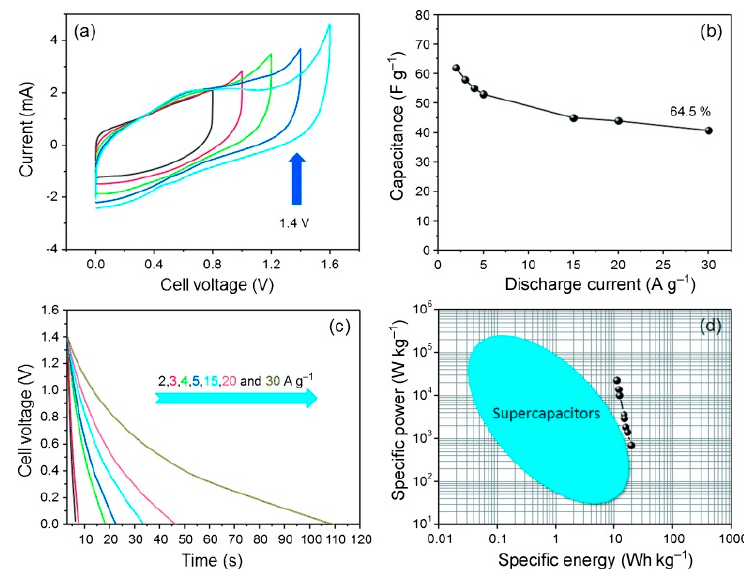
Figure 4. The electrochemical performance of SSC based on NPC-800 using 0.5 M H 2 SO 4 electrolyte. ( a ) Cyclic voltammograms at 20 mV s − 1 combined with diverse cell voltages (from 0.8 to 1.6 V). ( b ) Specific capacitances obtained by charge-discharge data with a cell voltage of 1.4 V. ( c ) Galvanostatic discharge curves at different current loads (from 2 to 30 A g − 1 ) with 1.4 V cell voltage. ( d ) Ragone plot [75].